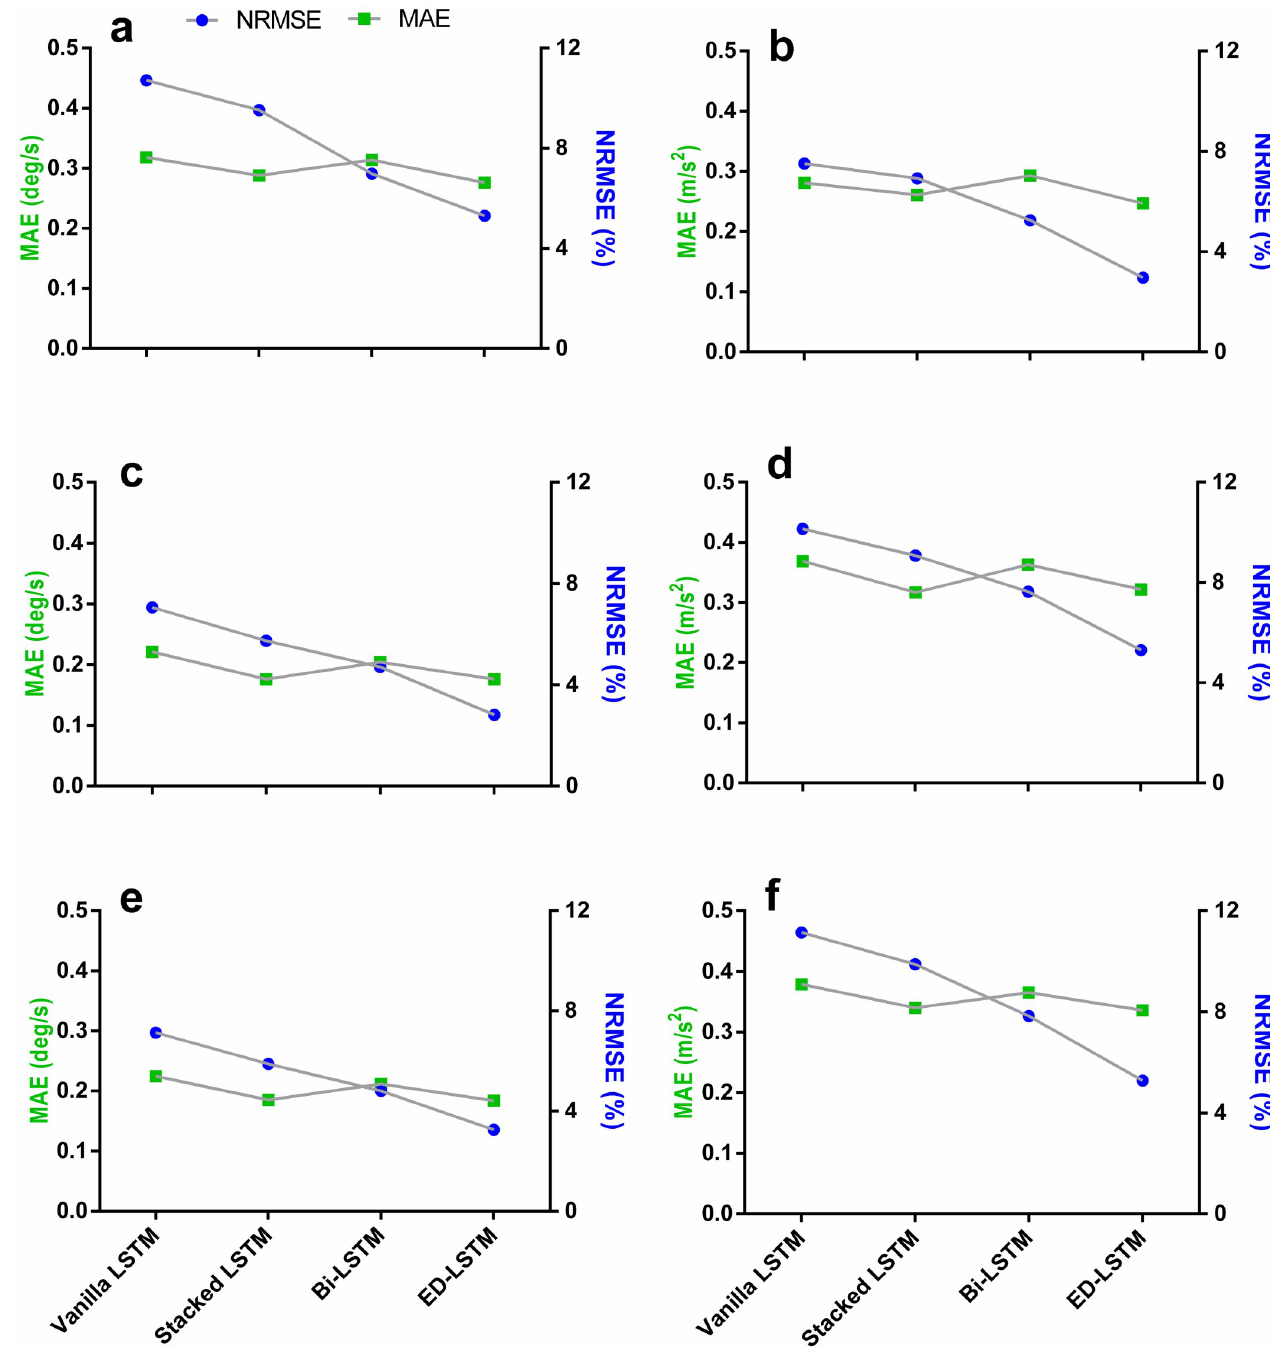
Fig 6. Performance comparison between LSTM models based on leave-one-out cross validation at PWS and 5km.h -1 for each feature vector. Green is the RMSE (Left Y-axis). Blue is the NRMSE (Right Y-axis). Lower error points for the MAE and NRMSE means a better predictive model for the related feature vector. (a) Foot AV ( X 1 ). (b) Foot LA ( Y 4 ). (c) Shank AV ( X 2 ). (d) Shank LA ( Y 5 ). (e) Thigh AV ( X 3 ). (f) Thigh LA ( Y 6 ).